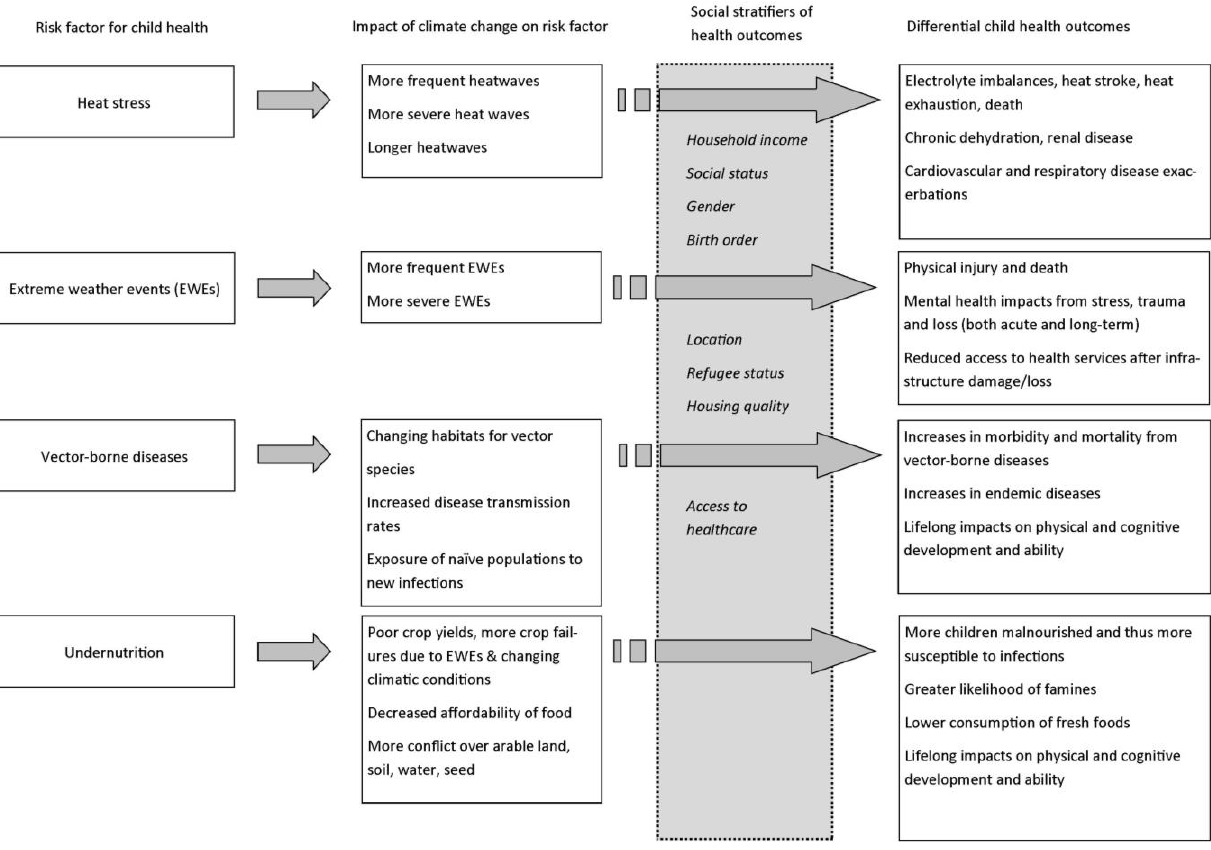
Figure 1. Pathways between selected environmental hazards, climate change, and social conditions that lead to differential health outcomes for